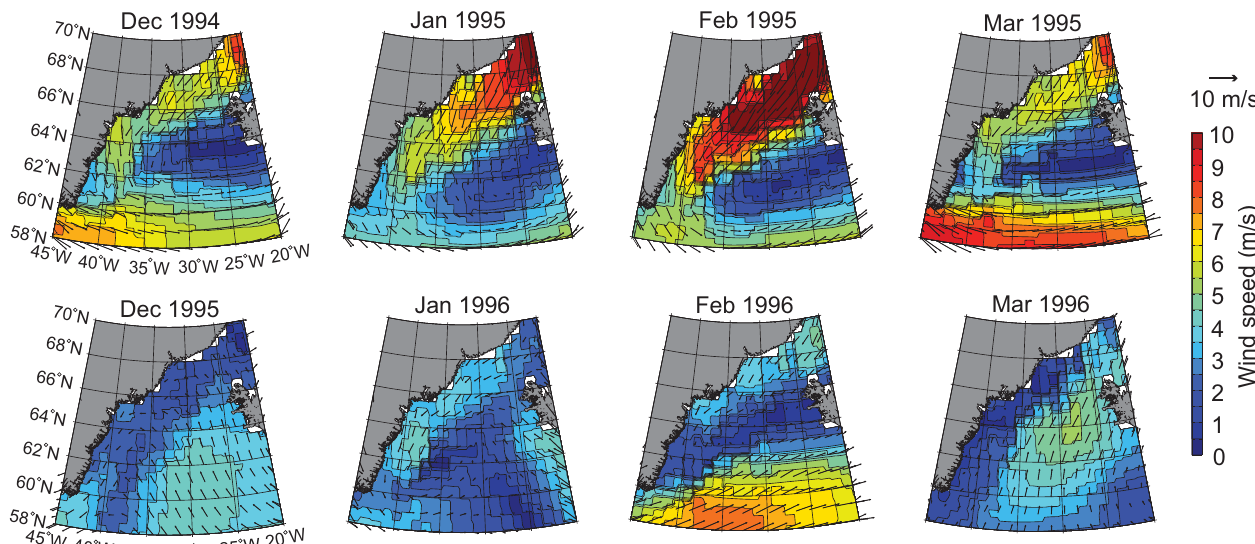
Fig. 9. Maps showing speed and direction of winds near the Denmark Strait during winters in 1994–1995 (top) and 1995–1996 (bottom). The data are from the atmospheric forcing set used to drive the ocean model (see text for